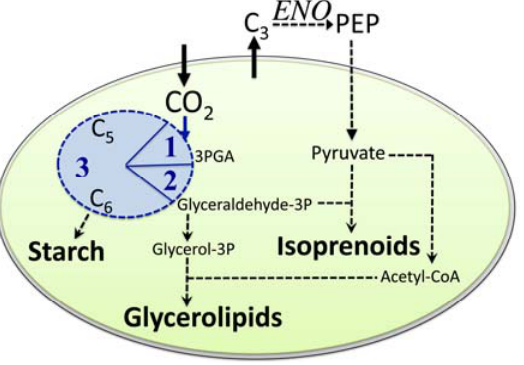
Figure 2. Simplified schematic showing our proposed path for carbon partitioning within the plastid of a green algal cell focused on starch, lipids, and isoprenoids. Note, that in into the plastid, also either pyruvate directly or a precursor addition to import of CO 2 metabolite needs to be imported that could then be converted into pyruvate. ENO indicates , C , and C represent monosaccharides with the enolase enzyme outside the plastid. C 3 5 6 three, five, or six carbon atoms, respectively. The blue circle represents the Calvin-Benson cycle with 1 = Carbon fixation, 2 = reduction phase, 3 = regeneration